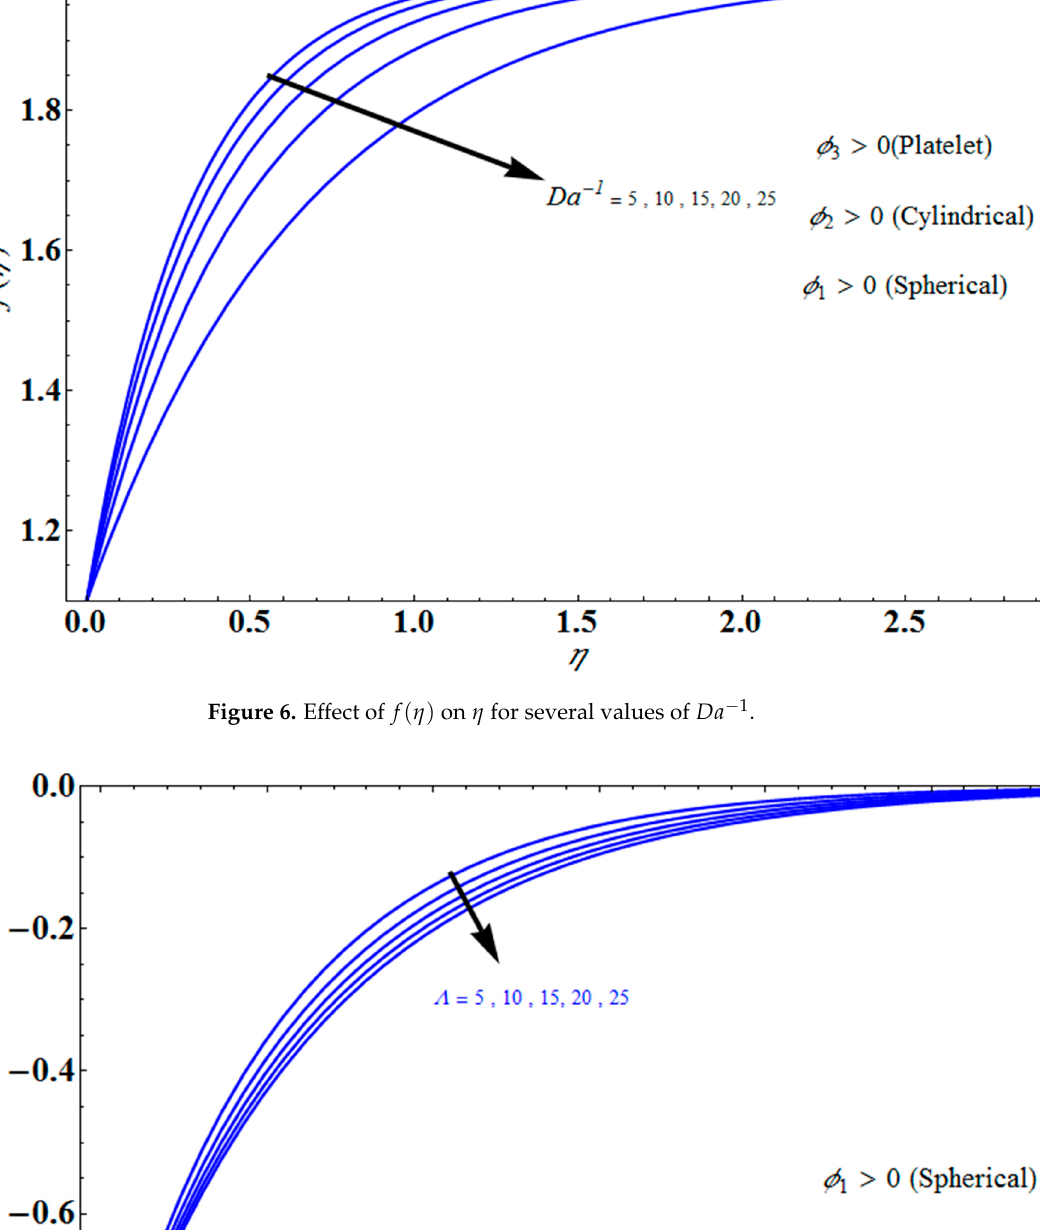
( ) η η f on for several values of η